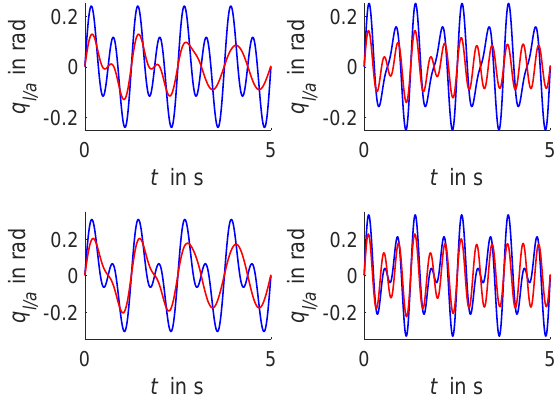
Figure 7. Adjustment of stiffness while tracking different dual sinusoidal trajectories; link (blue) and actuator (red) positions; base trajectory: sine with 10 ◦ and 1.6Hz; ( top-left ) superimposed by sine with 5 ◦ , 0.8Hz; ( top-right ) superimposed by sine with 5 ◦ , 2.4Hz; ( bottom-left ) superimposed by sine with 10 ◦ , 0.8Hz; ( bottom-right ) superimposed by sine with 10 ◦ ,